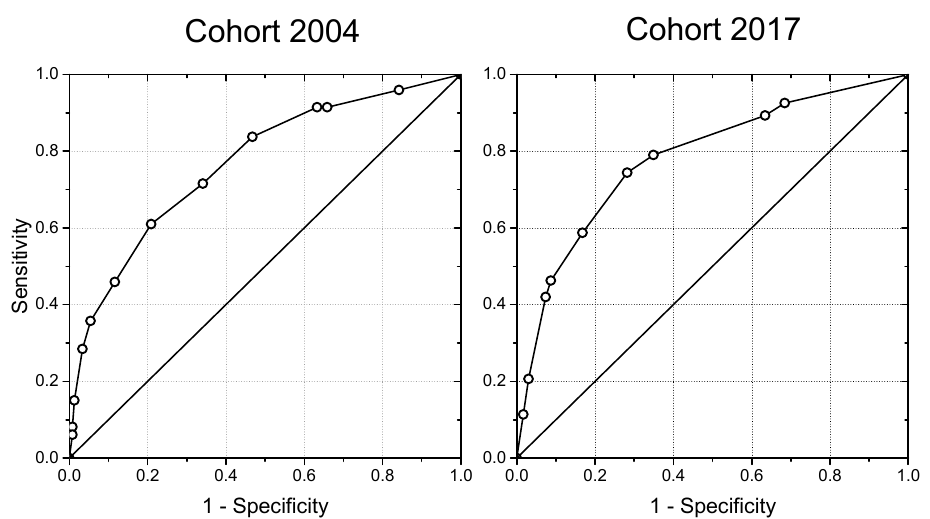
Figure 1. Receiver operating characteristic (ROC) curves for the breastfeeding scores in the validation 2004 ( n = 633) and 2017 ( n = 579) cohorts.